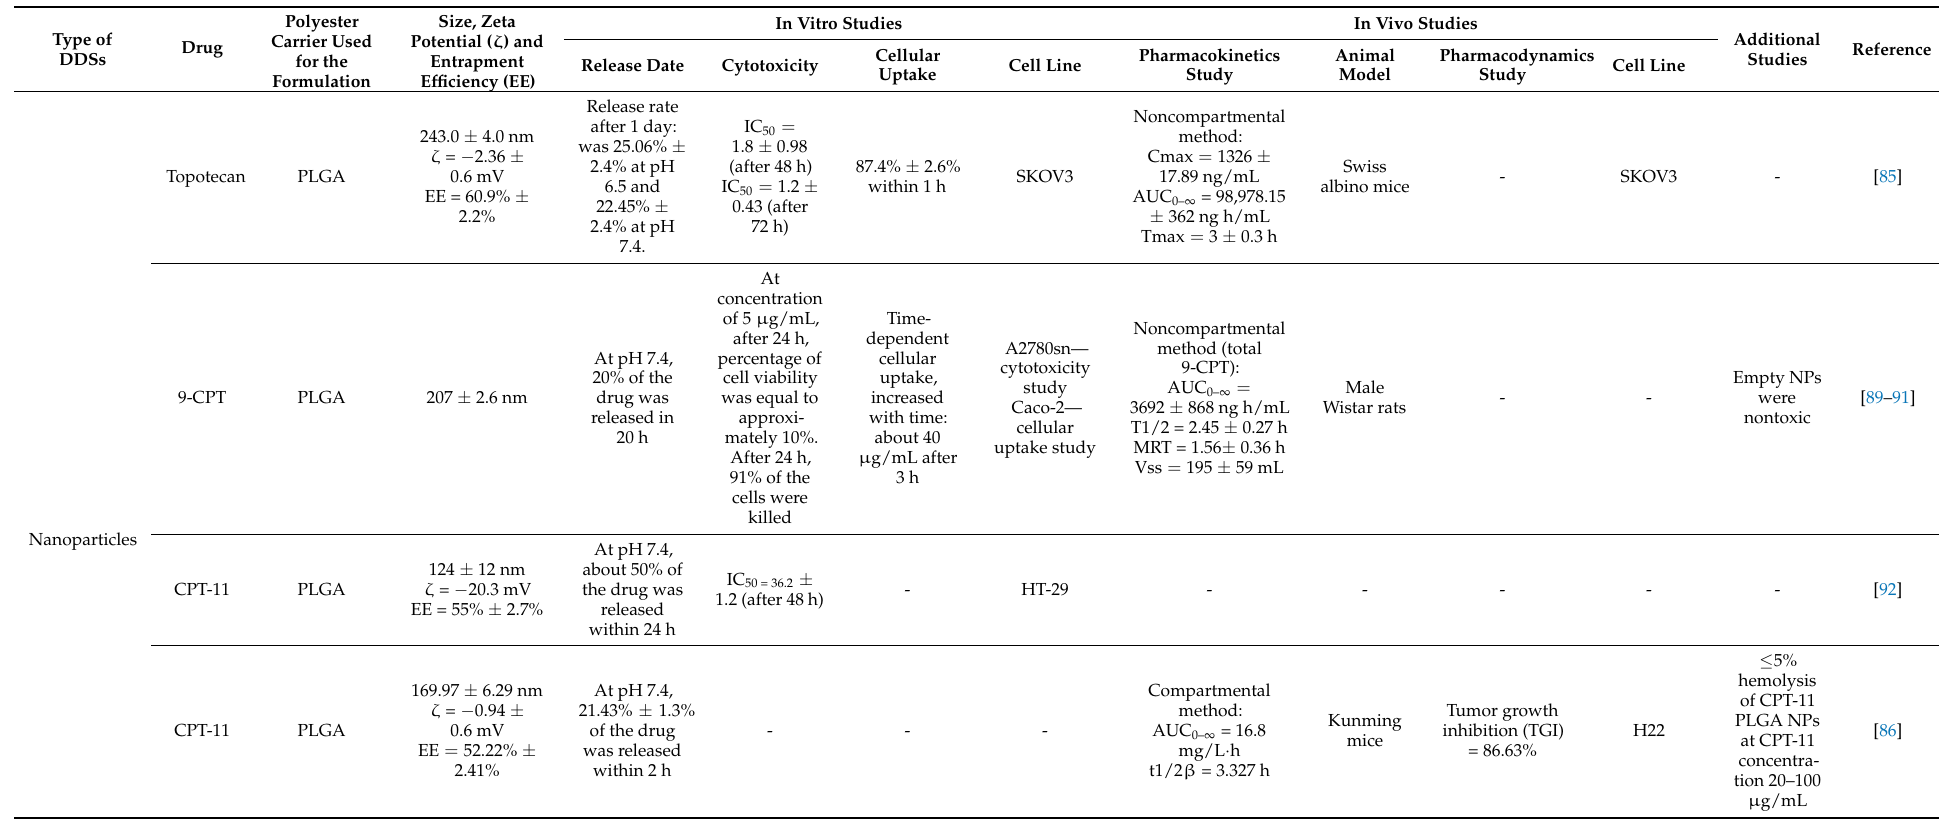
Table 2. Encapsulation and/or adsorption of CPT and its analogues to form different types of biodegradable polyester